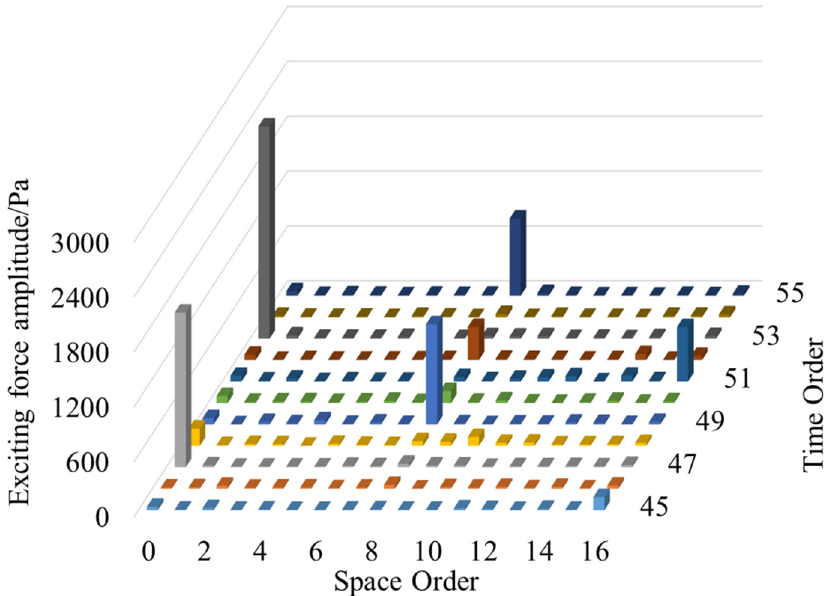
Figure 8. Two-dimensional Fourier decomposition results of the excitation force of the skewed slot motors at 3000 rpm.